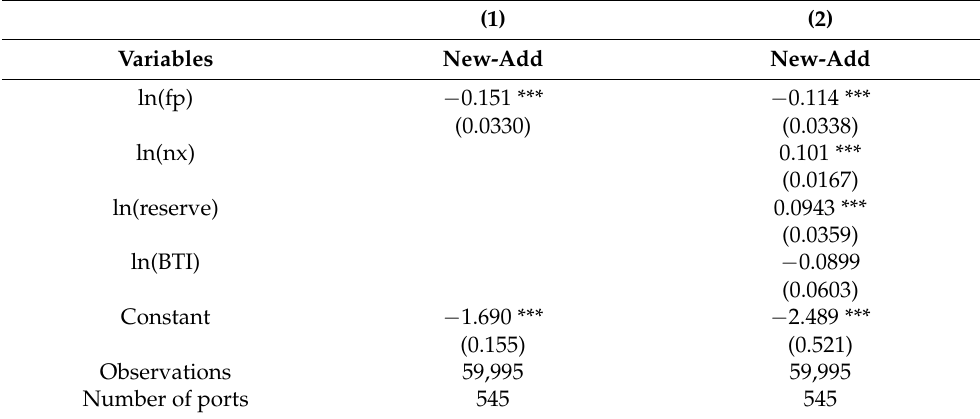
Table 6. Results of panel logit